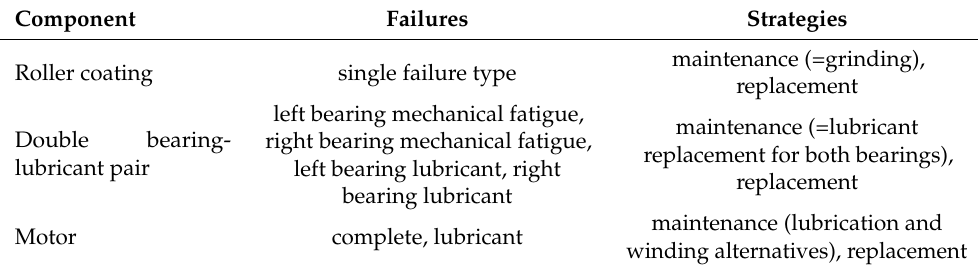
Table 14. Stops per component of the bleaching machine (ZORLUTEKS) involved in the relevant models discussed in this paper.